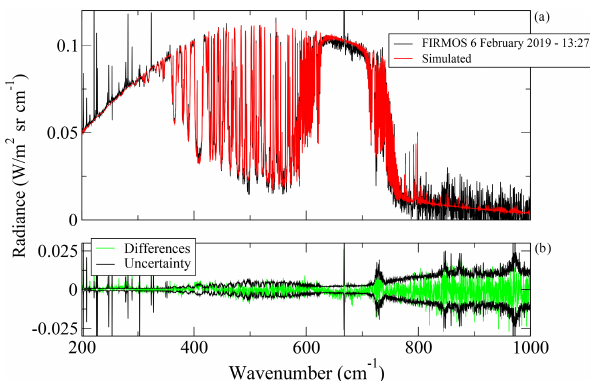
Figure 1. (a) The comparison of the FIRMOS measurement (black) in the presence of a cirrus cloud at 7.5km on 6 February 2019 at 13:27UTC with the simulated spectrum (red) at the last fit iteration. (b) The differences (green) between the measurement and simula- tion in comparison with the instrumental uncertainty (black).